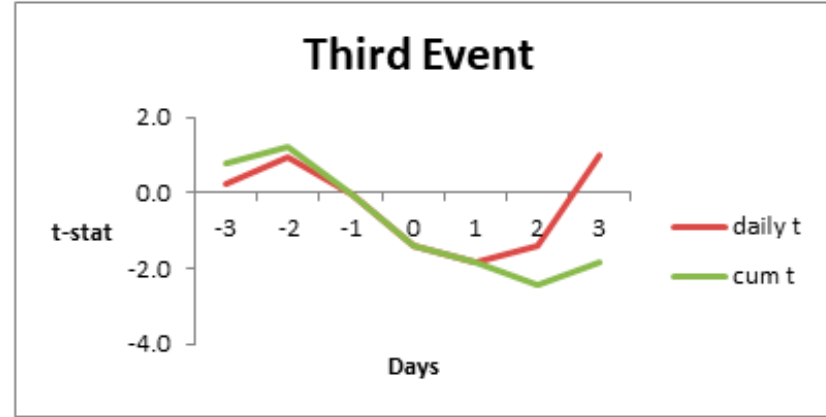
Figure 9. Daily t for AAR and cumulative t for CAAR. Source: Authors’ work.